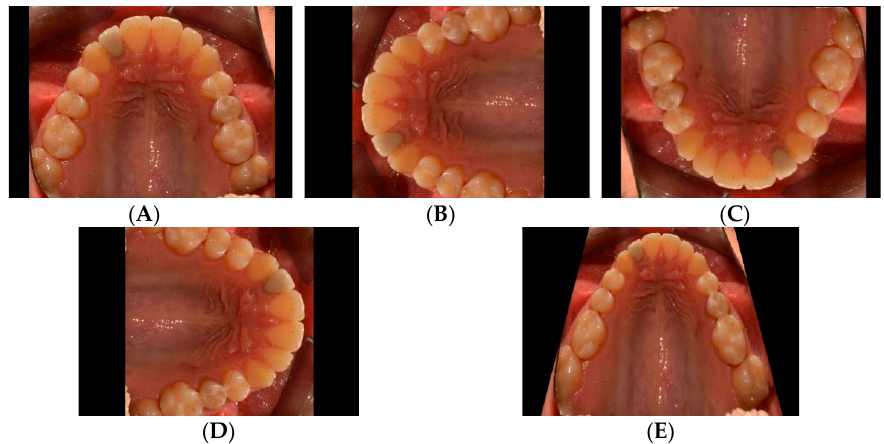
Figure 7. Data augmentation via rotation and perspective shrinking: Original image ( A ); 90° rotation ( B ); 180° rotation ( C ); 270° rotation ( D ); perspective ( E ).